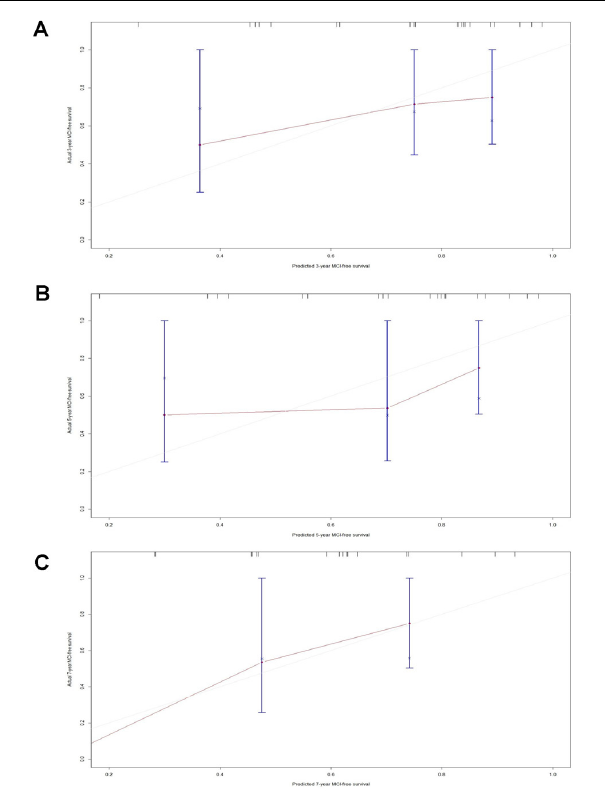
FIGURE 5 | Calibration plots of model 1-predicted probabilities of MCI-free survival at 3 years, 5 years, and 7 years in the validation set. Model-predicted probabilities of overall survival are plotted on the x-axis; actual overall survival is plotted on the y-axis. (A) The calibration curve of the model 1-predicted probability of MCI-free survival at 3 years in the validation set, n = 24. (B) The calibration curve of the model 1-predicted probability of MCI-free survival at 5 years in the validation set, n = 24. (C) The calibration curve of the model 1-predicted probability of MCI-free survival at 7 years in the validation set, n =